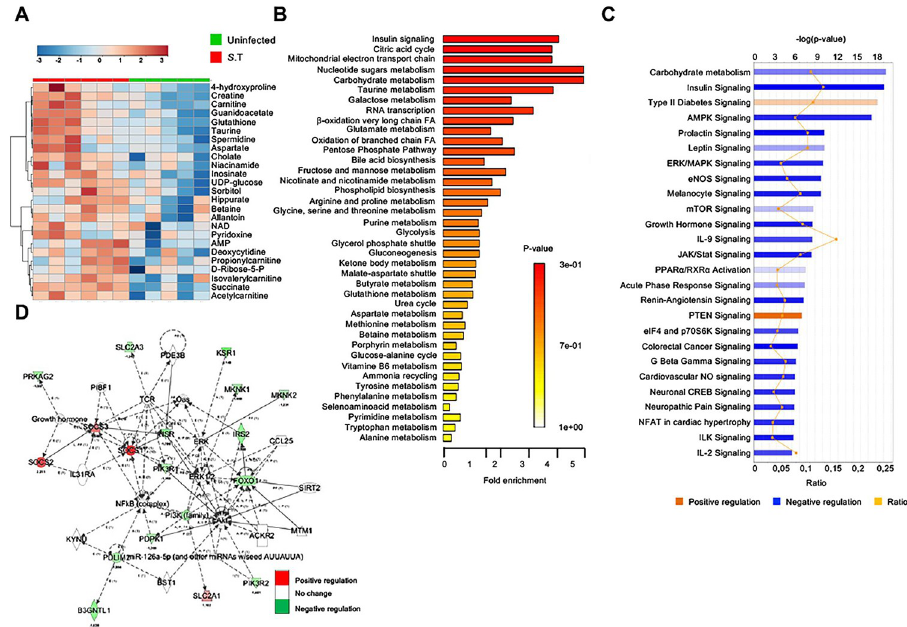
Fig 1. S . Typhimurium infection promotes metabolic reprogramming in macrophages. (A) Heatmap representation of 2-way hierarchical clustering of top-25 altered metabolites in BMDMs upon S. Typhimurium infection (2 h post-infection (p.i.) (n = 6) compared to uninfected controls (n = 5). (B) Metabolic pathway enrichment analysis of metabolomics data from S. Typhimurium-infected BMDMs (2 h p.i) compared to uninfected controls. (C) Ingenuity pathway analysis of genes differentially expressed in RNA-seq data from S. Typhimurium-infected BMDMs (2h p.i) compared to uninfected controls (n = 3). (D) Relative expression of genes from the insulin-signaling pathway in S . Typhimurium-infected BMDMs (2h p.i.) normalized to uninfected controls (n = 3).